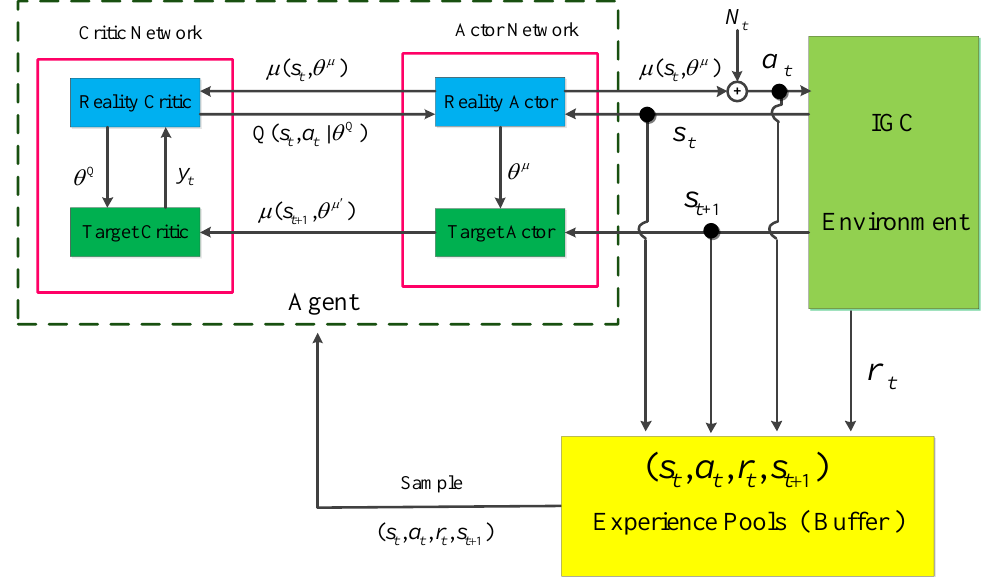
Figure 2. Block diagram of the IGC guidance law based on RL.